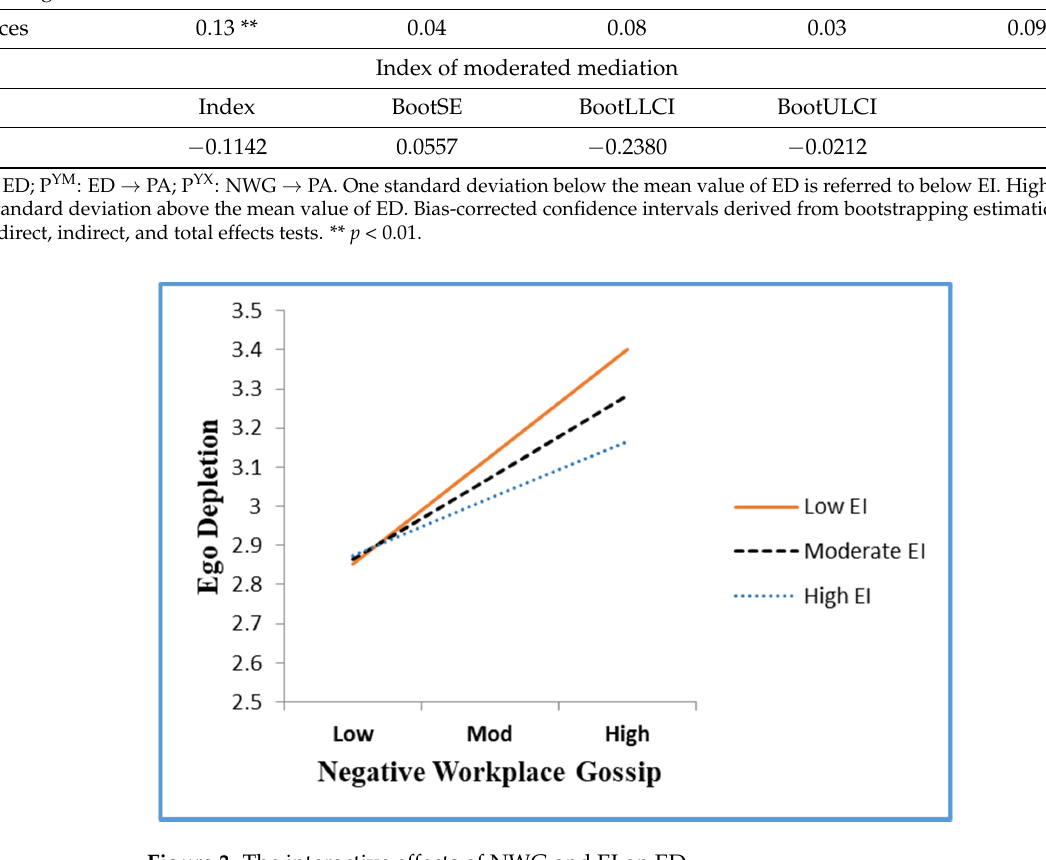
Table 5. Results of moderation mediation ( n = 277).